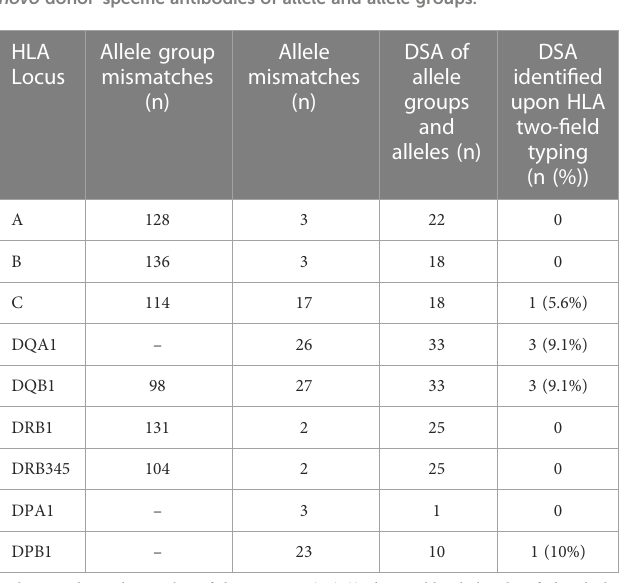
TABLE 2 The number of both cumulative allele group and allele mismatches (n) in our cohort for each HLA locus as well as identi fi ed de novo donor-speci fi c antibodies of allele and allele